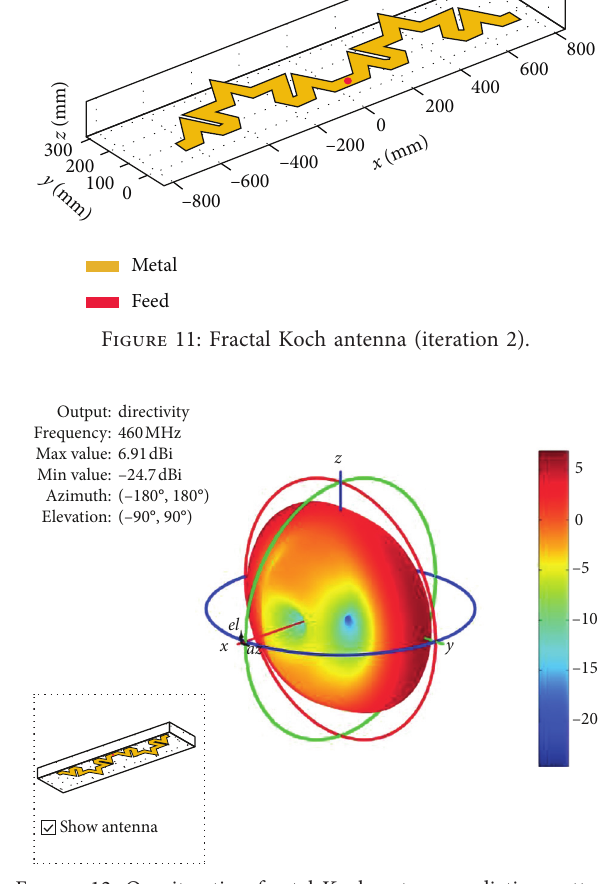
Figure 12: One-iteration fractal Koch antenna radiation pattern and phase at 460MHz.